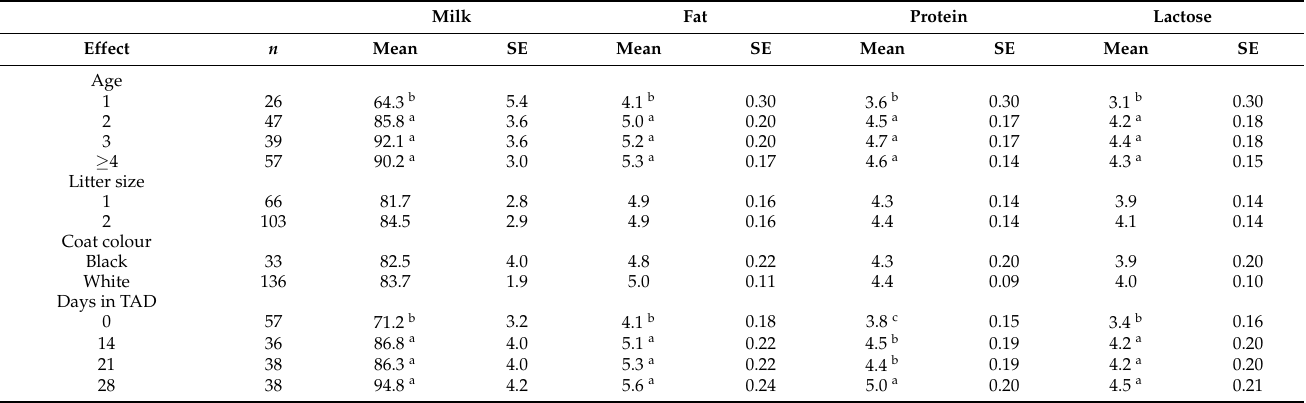
1 Lactation yields estimated from daily yields from 35 to 164 days of lactation. 2 Lactation persistency defined as yield from day 101 to 164 divided by yield from day 35 to day 100, expressed as percentage. 3 Average of SCS, calculated as SCS = Log 2 (somatic cell count). Statistical significance is given as * p < 0.05; ** p < 0.01; *** p < 0.001. Table 5. Least-squares means (Mean) and standard errors (SE) of lactation yields of milk (kg), fat (kg), protein (kg), and lactose (kg) estimated for 130 days after weaning for different ewe ages (year), litter sizes, coat colours, and days in twice-a-day (TAD) milking at Kingsmeade farm during the production season 2021–2022. Milk Fat Protein Lactose